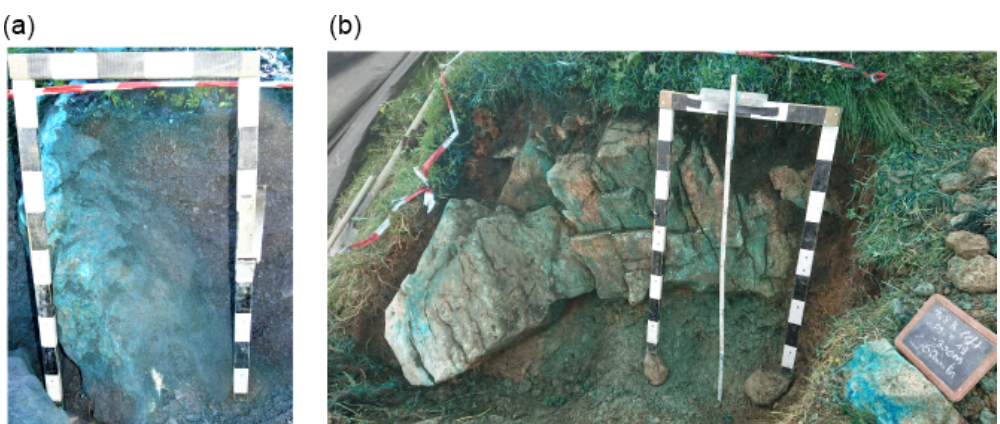
Figure A1. Hidden boulders at the 160a (a) and 4.9ka (b) moraine. The boulder occupied most of the cross section of the subplot irrigated with 40mmh − 1 at plot 1 of the 160a and most of the cross section of plot 2 at the 4.9ka moraine. Due to this strong disturbance, the corresponding plot and subplot were neglected in the further analyses. The length of one black or white scale segment of the wooden frame equals 10cm.